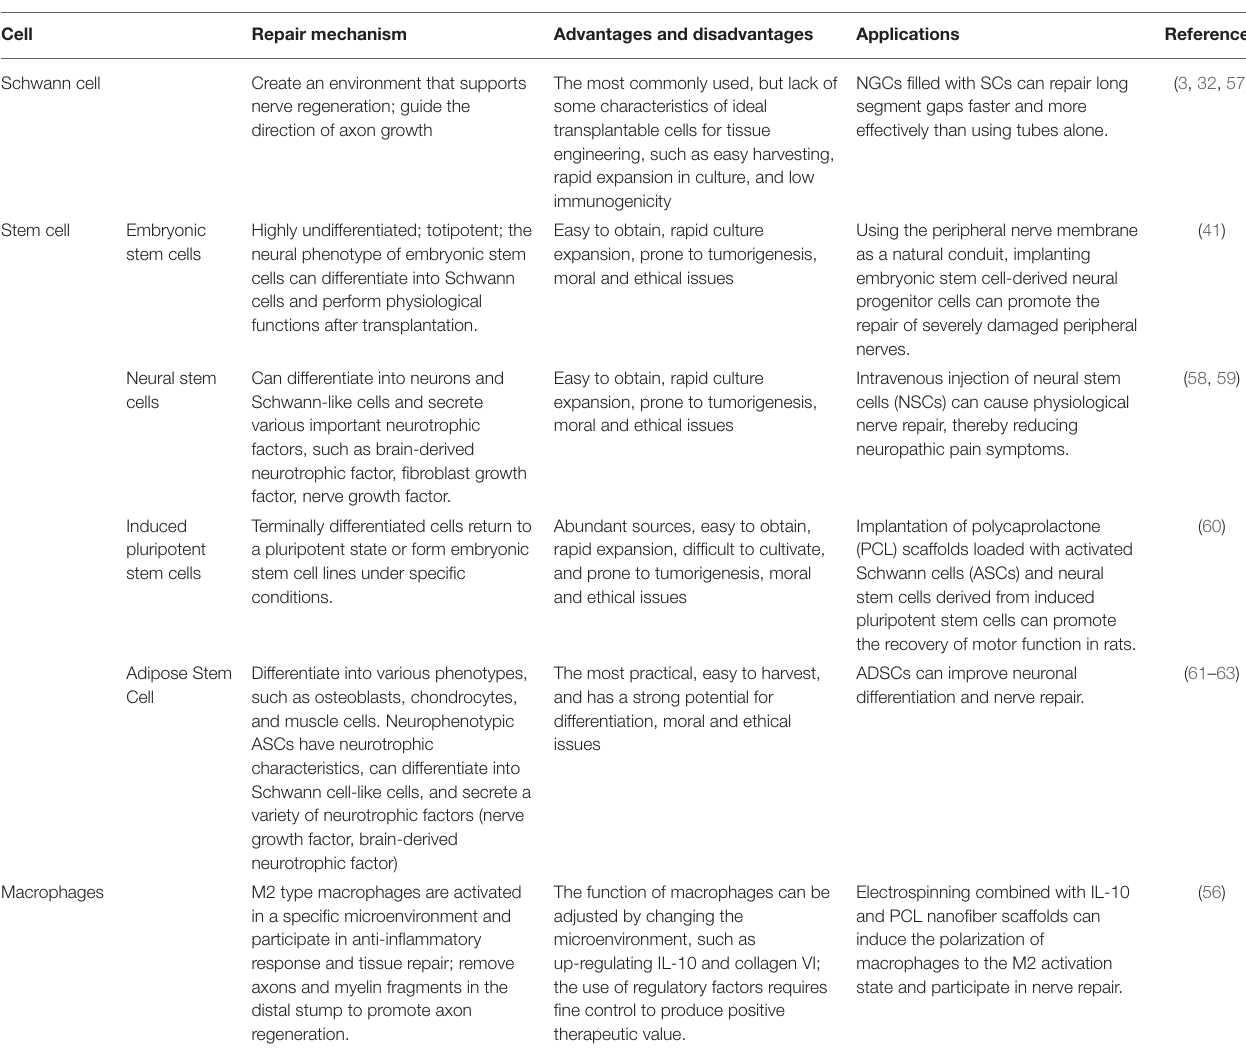
TABLE 4 | Commonly used cells in neural tissue